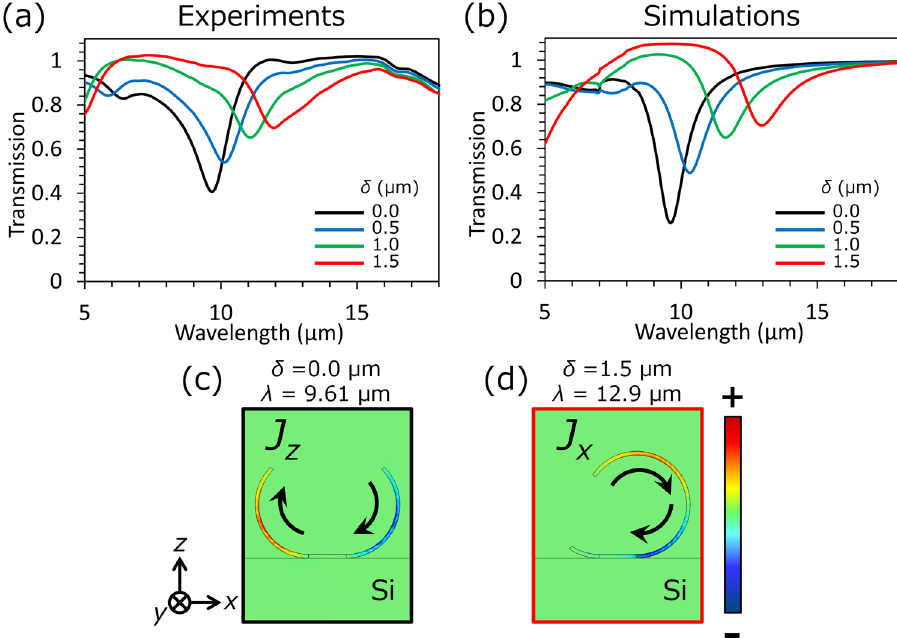
Figure 4. ( a ) Experimental and ( b ) simulated transmission spectra for 3D-SRRs with the patch shift δ . ( c ) A z- component of a current distribution flowing along the ring in the case of δ = 0.0 μ m. ( d ) An x- component of a current distribution flowing along the ring in the case of δ = 1.5 μ